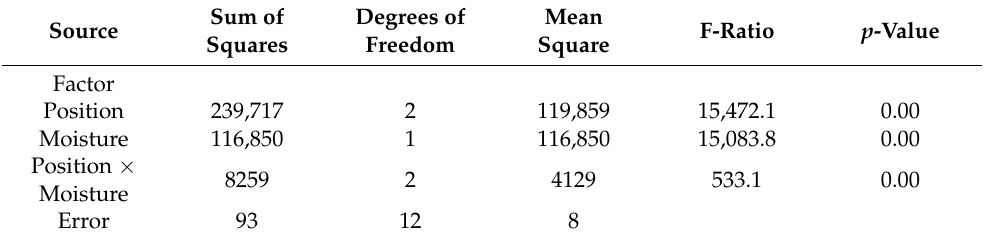
Table 3. Multifactor ANOVA with F-ratios and p -values for the factors that affected CO 2 emission: position (top, mid-slope, bottom of the gully) and moisture (9% and 12% v/v ), and their interac- tion.